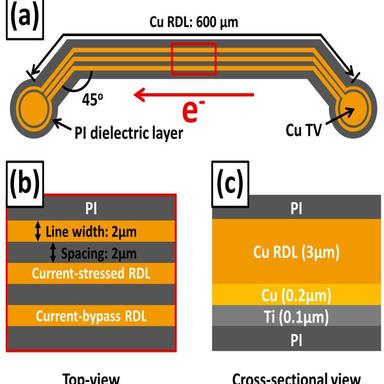
(a) A schematic drawing of the advanced Cu RDL structure embedded in PI dielectric layers for the electromigration experiment; (b) and (c), respectively, enlarged top-view and cross-sectional sketches of the confined Cu RDL region in (a). (Single-column; Color online). (For interpretation of the references to color in this figure legend, the reader is referred to the Web version of this article.)